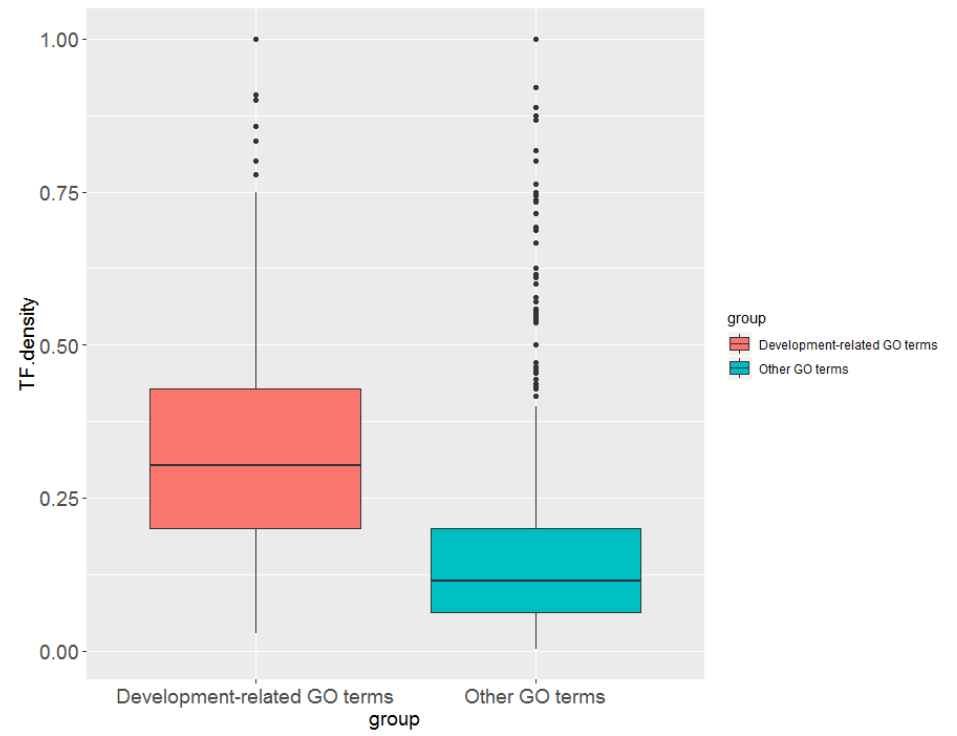
Figure 5. Comparison of TF density in development-related GO terms vs. all other terms.